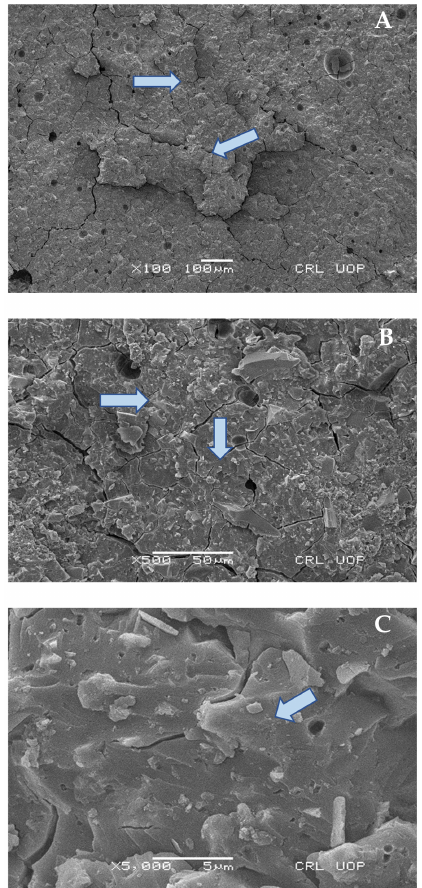
Figure 8. Failure mode of GIC + Ceram X (Group B), cohesive failure under scanning electron microscope. Blue arrows indicate magnified cohesive failure regions, ( A ) 100×, ( B ) 500×, and ( C ) at 5000× magnifcation.